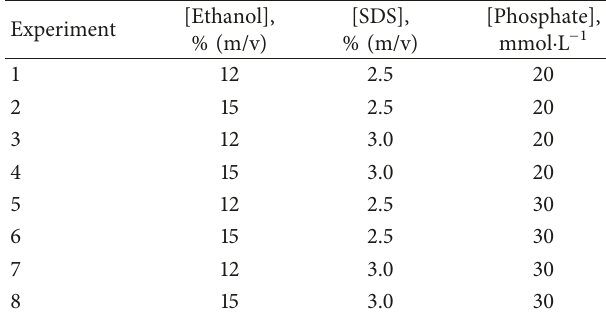
Table 1: Factorial experiment 2 3 to optimize the separation of the